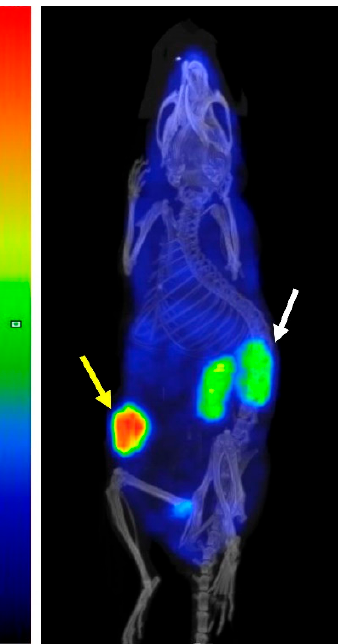
11 of 15 Figure 6. Biodistribution at 48 h post injection. ( A ) Biodistribution of [ 177 Lu]Lu-PEP40233 in BALB/C nu/nu mice bearing SKOV-3 and BxPC3 xenografts. Data are presented as an average value from four mice ± SD. The data show higher accumulation in xenografts with higher HER2 expression. ( B ) Comparison of biodistribution of [ 177 Lu]Lu-PEP40233 and [ 177 Lu]Lu-ABY-025 in SKOV-3 bearing xenografts. Data are presented as an average value from four mice ± SD. The data show clear reduc- tion in the renal uptake and extension of residence in circulation for [ 177 Lu]Lu-PEP40233.